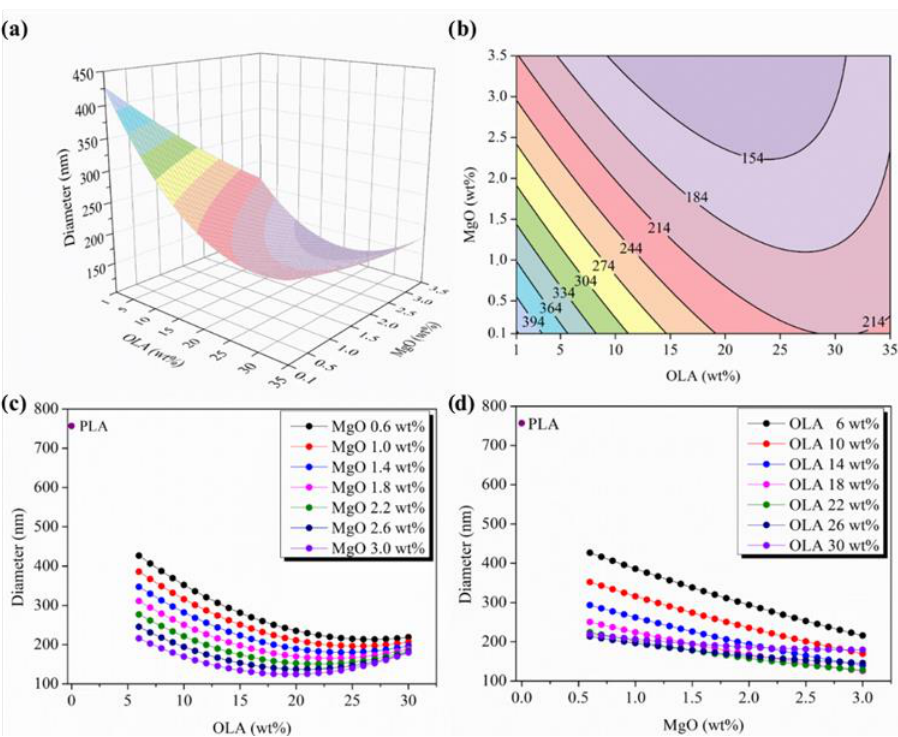
Figure 4. ( a ) 3D response surface plot and ( b ) contour plot of the diameter as a function of OLA and MgO NPs content, colours changes are attributed to an increment of 30 nm in the average diameter of efibers. ( c ) Parametric evolution of diameter with OLA content remaining constant the MgO NPs levels. ( d ) Parametric evolution of diameter with MgO NPs content remaining constant the OLA amounts.